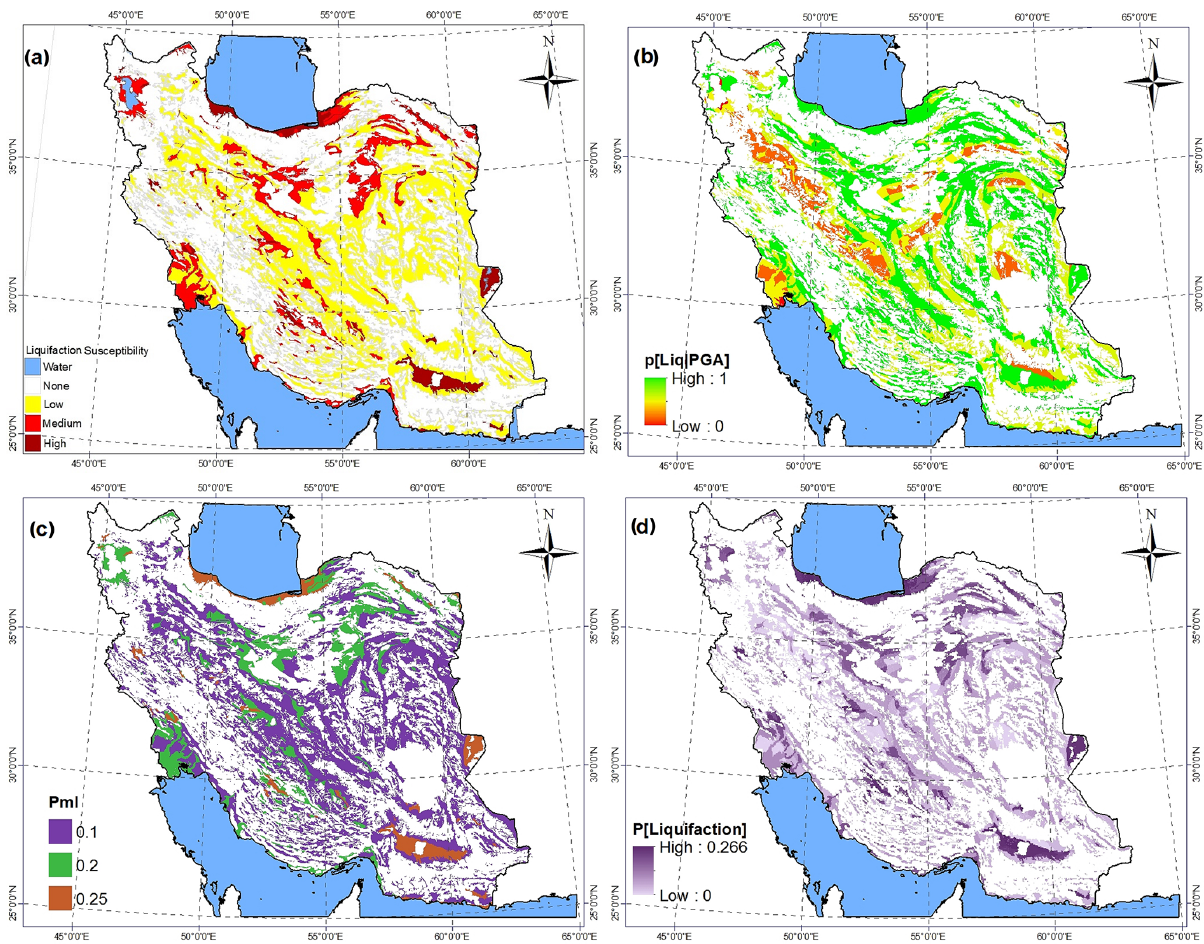
Figure 9. (a) Liquefaction susceptibility map, (b) conditional liquefaction probability map, (c) proportion of map unit susceptible to lique- faction, (d) liquefaction probability map.